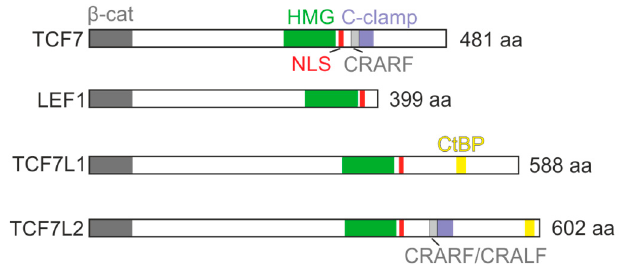
Figure 1. Major functional domains present in TCFs. The diagrams show the position of conserved functional domains in the TCF/LEF family members encoded by Ensemble database transcripts ENST00000395029 (encodes human TCF7), ENST00000265165 (LEF1), ENST00000282111 (TCF7L1), ENST00000627217 (TCF7L2). β‐ cat, β‐ catenin ‐ binding domain (gray); HMG, High mobility group ‐ box DNA ‐ binding domain (green); NLS, nuclear localization signal (red); C ‐ clamp, C ‐ clamp DNA ‐ binding motif (blue); CtBP, the domain mediating interaction with the C ‐ terminal binding protein (yellow). The grey bands in the C ‐ clamp motif represent the position of the CRARF/CRALF sequences that contain the first cysteine residue (of four in total) essential for helper sequence binding; aa, amino acids. For the sake of clarity, the size of boxes representing the NLS signal and CRARF/CRALF sequences (in this and other figures) does not correspond to the scale of other depicted domains.